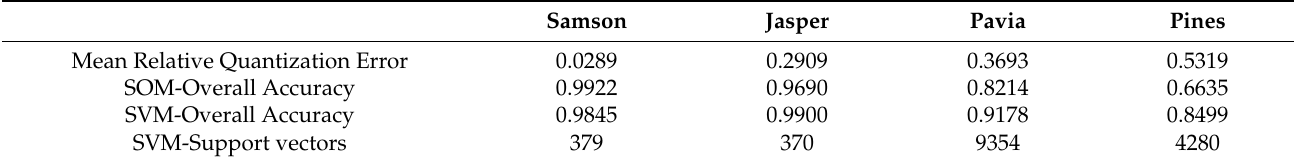
Table 7. Performance of several classifiers on different scenes.